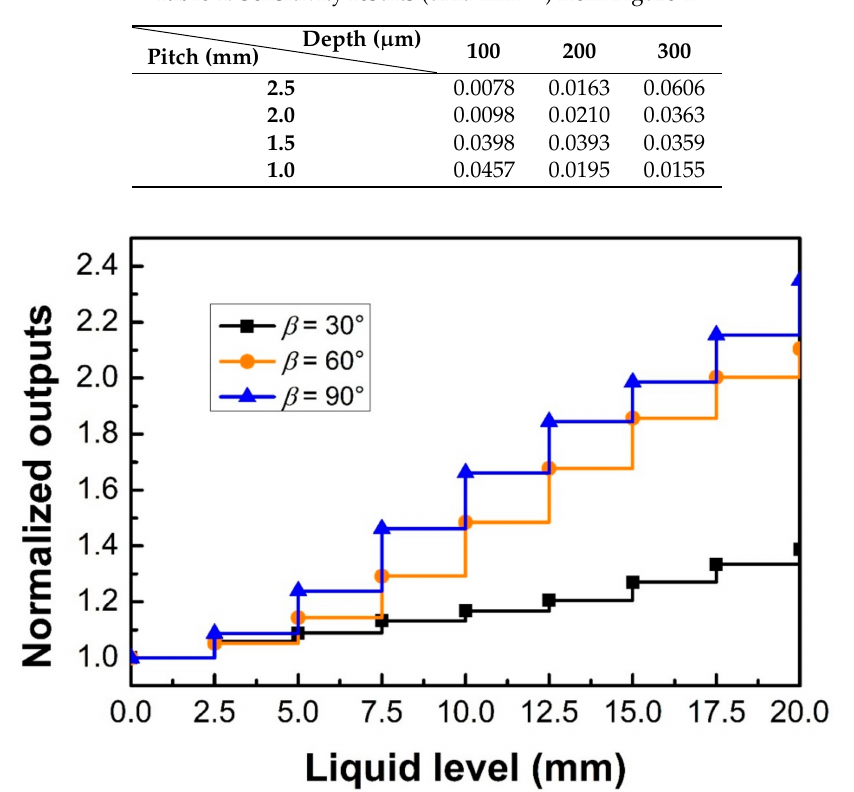
Table 1. Sensitivity results (unit: mm − 1 ) from Figure 4.